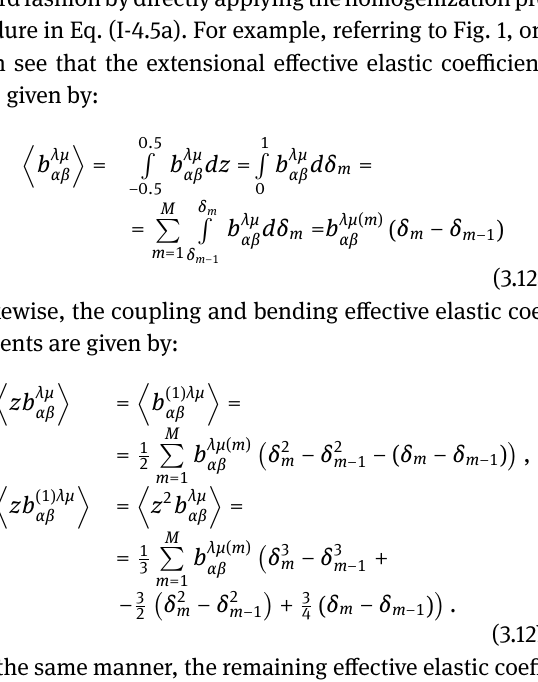
Table 1: Material properties of BaTiO 3 , and CoFe 2 O 4 (Li and Dunn [69], Yoshihiro and Tanigawa, [70], Cook et al., [71]).